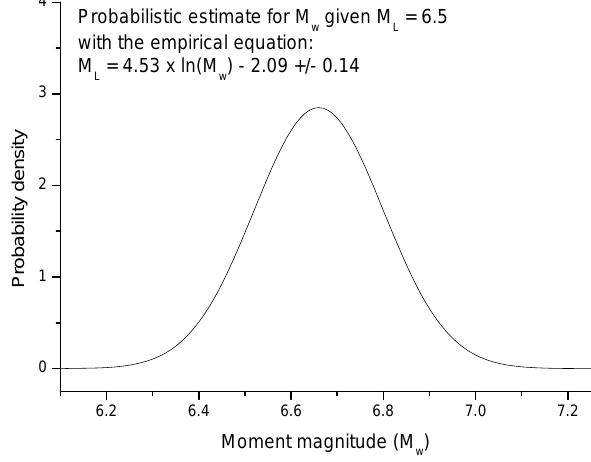
Fig. 1. An example showing the conversion from M L to M w on a probabilistic basis.